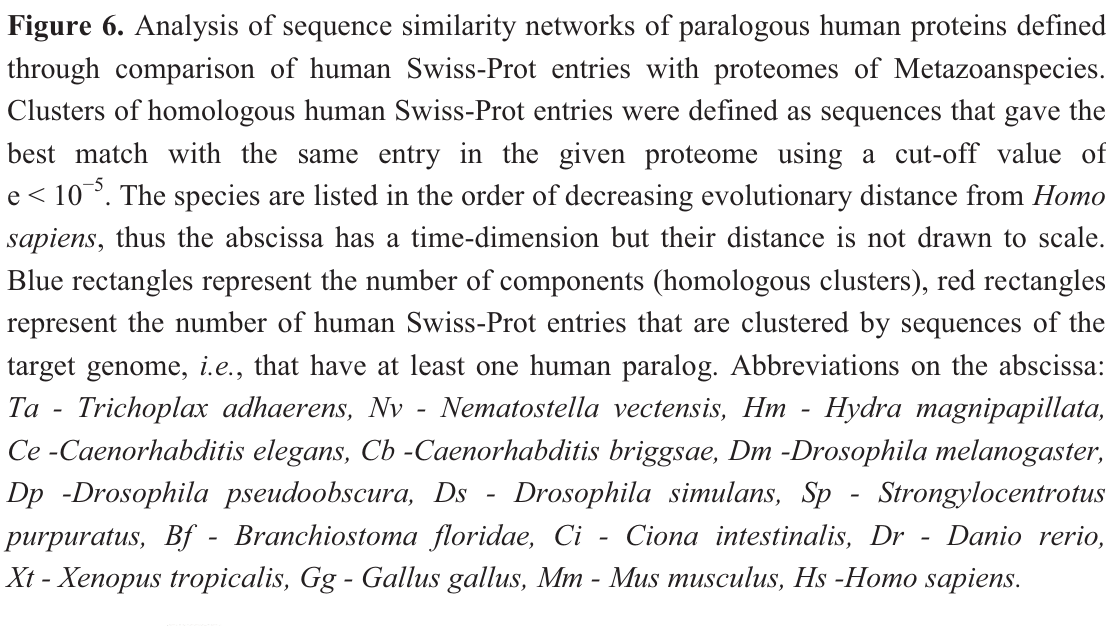
Figure 6. Analysis of sequence similarity networks of paralogous human proteins defined through comparison of human Swiss-Prot entries with proteomes of Metazoanspecies.